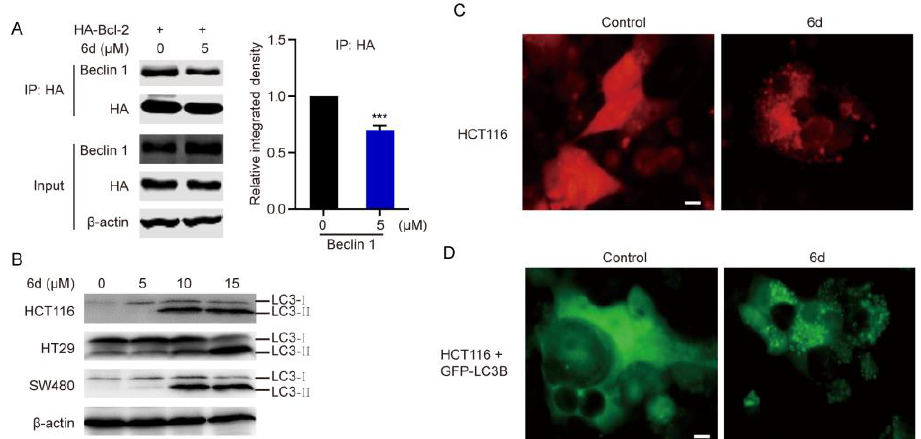
Figure 3. Compound 6d initiates autophagy and contributes to the formation of autophagosomes by releasing Beclin 1 from Bcl-2. ( A ) HCT116 cells were transfected with HA-Bcl-2, and then treated with or without 5 μM compound 6d for 8 h. Co-IP was performed using HA antibody to detect the interaction between Bcl-2 and Beclin-1. *** p < 0.001 versus vehicle. ( B ) Western blotting analysis of LC3B in CRC cells treated with indicated concentrations of compound 6d for 8 h. β-actin level was used as an internal load control. ( C ) Immunofluorescence analysis of the endogenous LC3 dots signal in HCT16 cells treated with or without compound 6d for 4 h and stained with LC3B antibody. Red signal indicated the endogenous LC3B puncta formation. ( D ) Fluorescence analysis of exogenous LC3 dots signal in HCT16 cells transfected with GFP-LC3 after treatment with or without compound 6d . Scale bar: 10 μm.